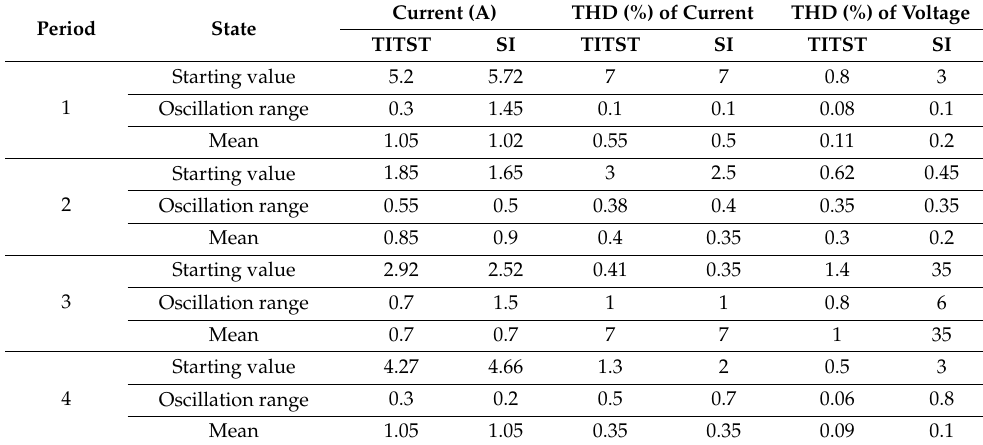
Table 5. Assessment of current, THD in current, and THD voltage to TITST against SI controllers.